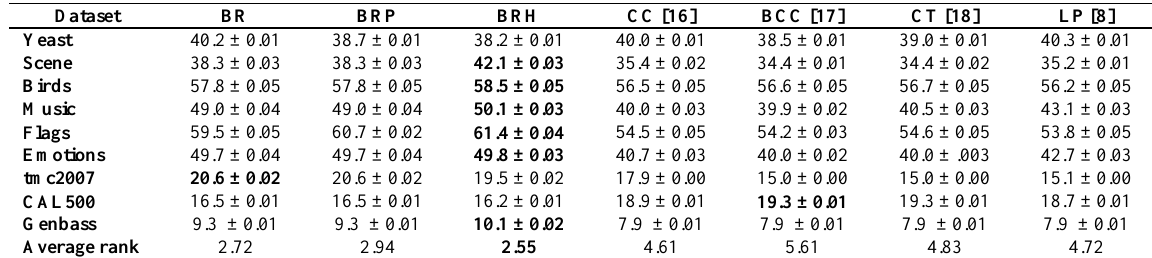
Best results are shown boldface.